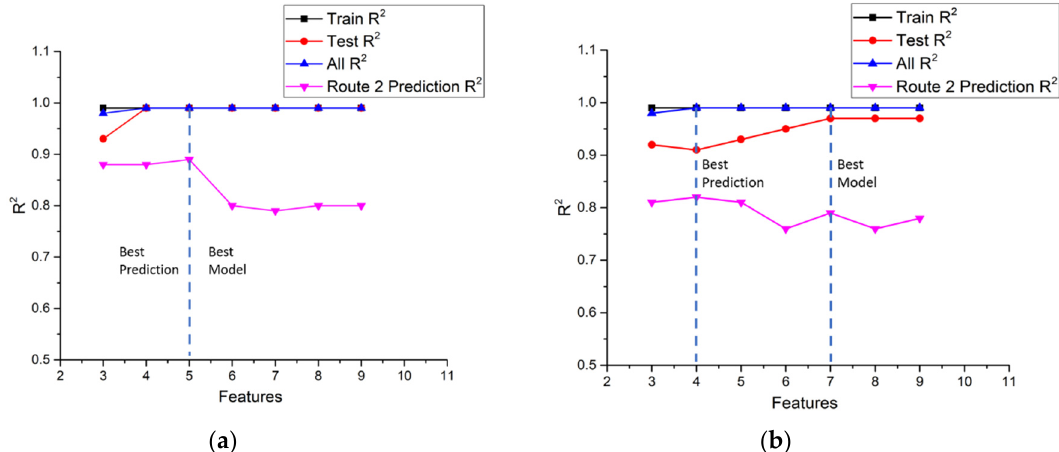
Figure 11. ( a ) Comparisons of the R 2 value of NO x models for the training sub-dataset, the test sub-dataset, all data, and the route 2 prediction in suburbs; ( b ) Comparisons of the R 2 value of CO 2 models for the training sub-dataset, the test sub-dataset, all data, and the route 2 prediction in suburbs.